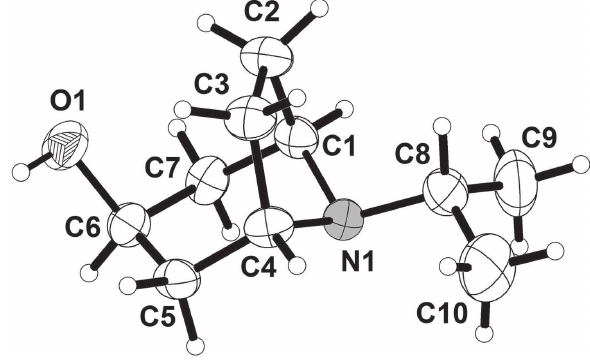
Table 2: Fractional atomic coordinates and isotropic or equivalent isotropic displacement parameters (Å 2